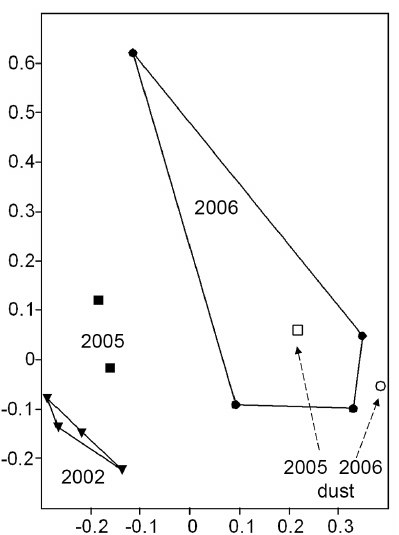
Figure 5. Non-metric multidimensional scaling ordination of 6000 m microbial communities sampled in autumn of 2002 ( . ), 2005 ( & ) and in spring 2006 ( ) next to corresponding 2005 autumn ( % ) and spring 2006 ( # ) dust samples. Note - no significant groups could be identified using NP-MANOVA (0.05 , p , 0.12). Samples from the same group were connected by lines and represent convex hulls of NM-MDS scores of microbial communities as a measure of community-space covered.